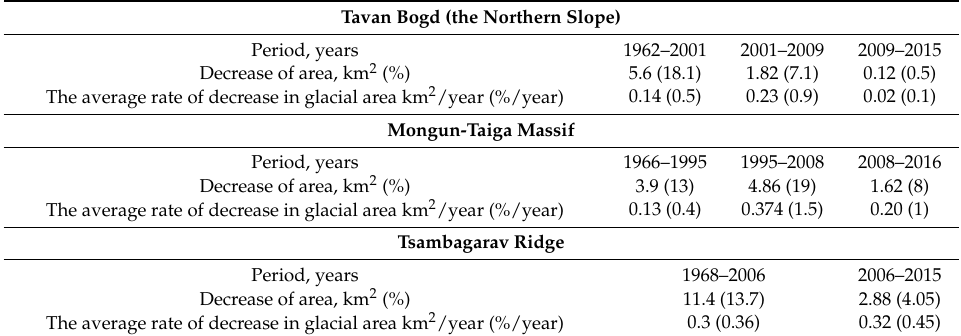
Table 4. Reconstructed rate of degradation of the glaciers of some glacial centers of arid Altai since